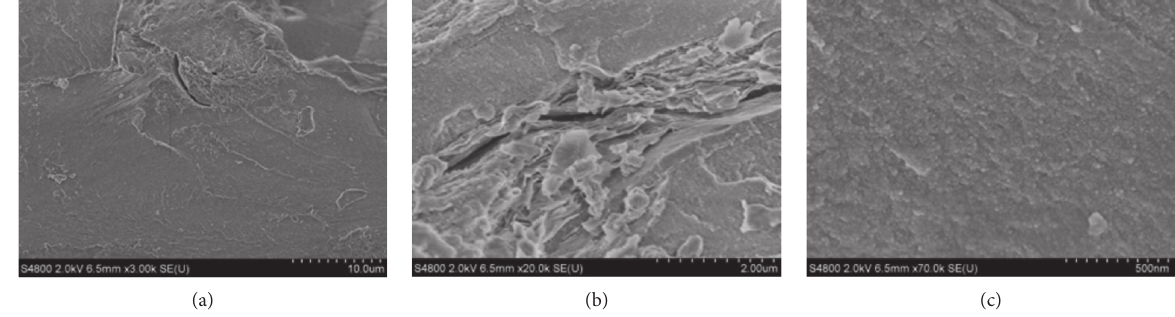
Figure 1: SEM images of samples in Bulianta Coal Mine at different magnifications (3000, 20000, and 70000x from left to right).